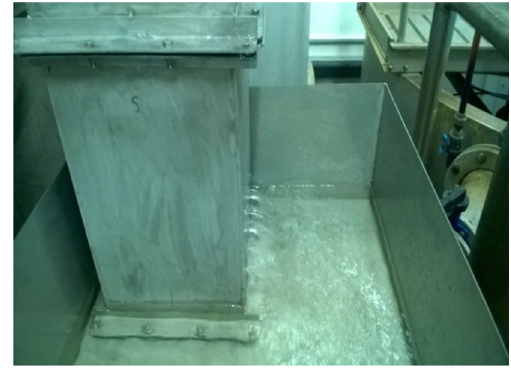
Fig. 3 Last segment of the aerator with aerated water